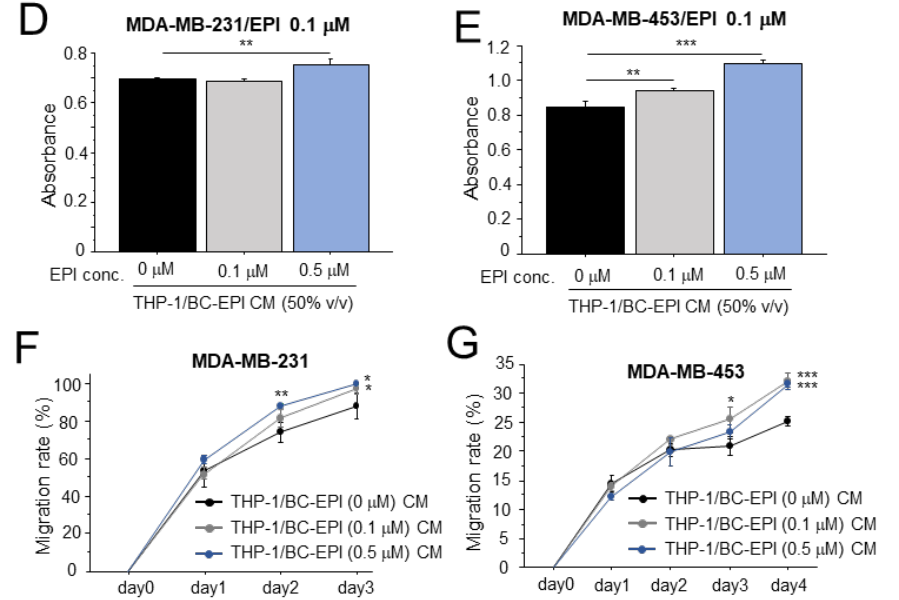
Figure 1. Effects of breast cancer cells following chemotherapy on the pro-tumorigenic ability of macrophages. ( A ): Schematic image of coculture experiments to investigate the effects of breast cancer cells treated with epirubicin (EPI) on the pro-tumorigenic activity of macrophages. ( B – G ): Cell proliferation ( B , C ), resistance to EPI ( D , E ), and migration ( F , G ) assays in MDA-MB-231 ( B , D , F ) and MDA-MB-453 ( C , E , G ) cells using conditioned medium (CM) from macrophages that had interacted with EPI-treated breast cancer cells (THP-1/BC-EPI CM, 50% v / v ). The concentration of EPI is indicated in the figure. Cell viability was measured 72 h after the CM treatment. Cell migration was examined with a wound healing assay using MDA-MB-231 and MDA-MB-453 cells treated with THP-1/BC-EPI CM (50% v / v ). The data are presented as the mean ± S.D. ( n = 3). * p < 0.05, ** p < 0.01, *** p < 0.001 vs. control (EPI 0 µ M). BC: breast cancer, CM: conditioned medium, EPI: epirubicin.